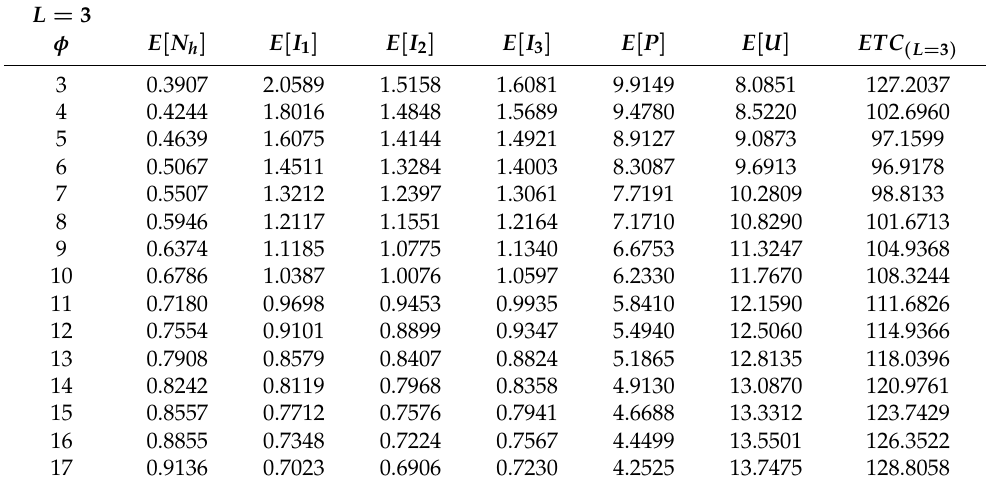
Table 7. Effect of φ on various performance measures and ETC per unit time ( L = 3).